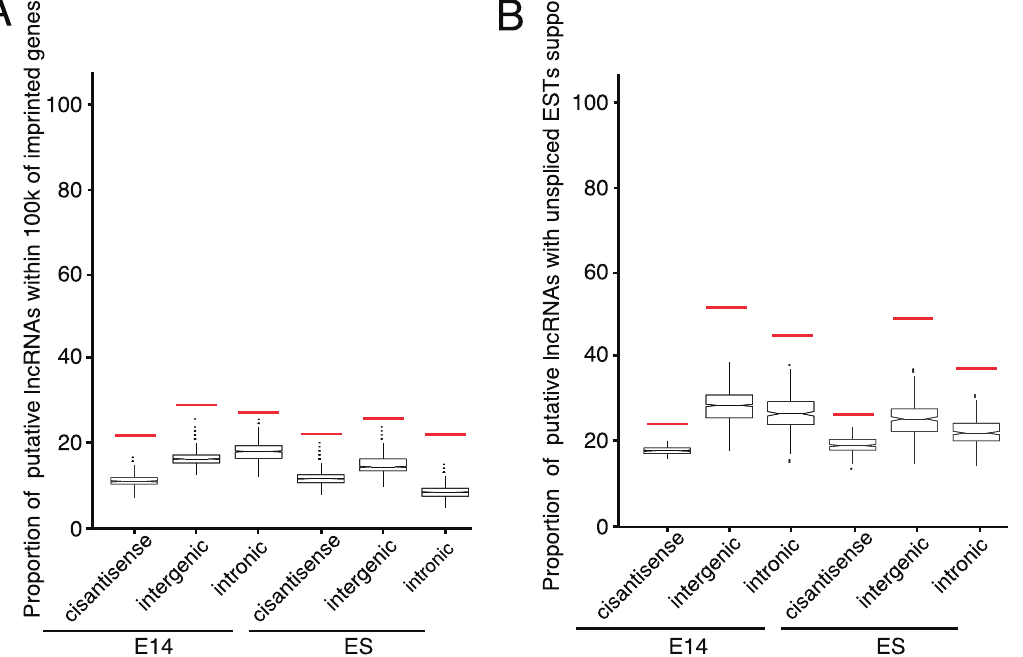
Figure 6. Putative embryonic brain lncRNAs are related to imprinted genes and unspliced ESTs. (A) Shown are the proportions of putative lncRNAs and permutated lncRNAs within 100k distance of compiled imprinted genes. Putative embryonic brain lncRNAs are involved in imprinted regions, comparable with putative lncRNAs in ES cell. (B) Shown are the proportions of putative lncRNAs and permutated lncRNAs that overlap with unspliced ESTs. Putative lncRNAs are significantly overlapped with unspliced ESTs. Embryonic, lncRNAs expressed at embryonic stages; ES, lncRNAs expressed at the ES stage; Red bar, the proportion of lncRNAs; Box, the proportion of permutated lncRNAs; whiskers denote the 10th and 90th percentiles.